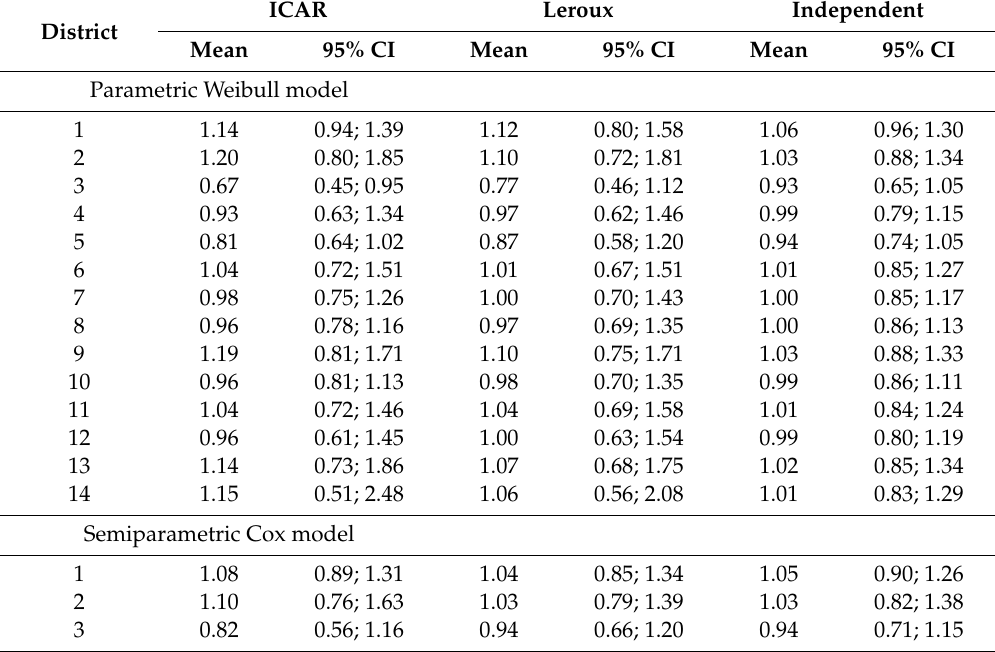
Table 4. Estimation of spatial random e ff ect (spatial frailty) hazard ratios for Weibull and Cox models. District numbers correspond to Table